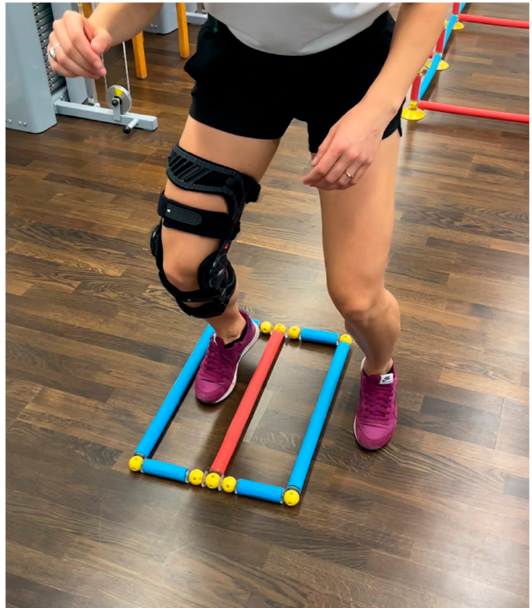
Figure 2. Quick feet test.